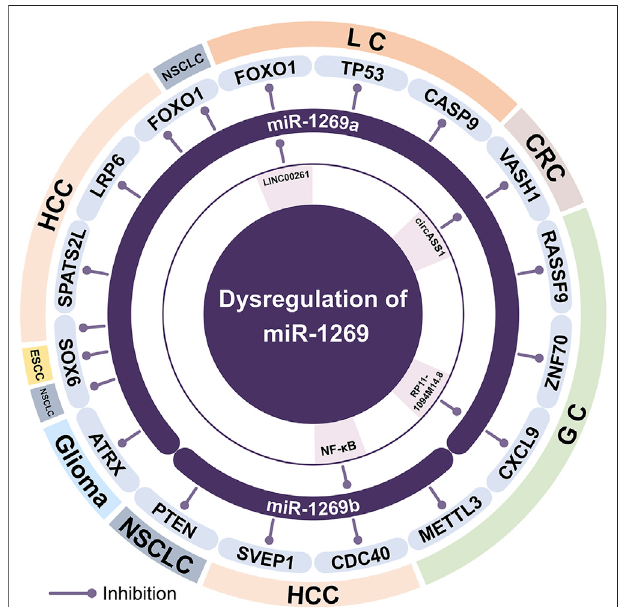
FIGURE 1 | The dysregulation of miR-1269a and miR-1269b in different cancers. miR-1269a can be regulated by three upstream ncRNAs. miR- 1269a and miR-1269b can regulate the occurrence and development of cancer by targeting downstream genes. HCC, Hepatocellular carcinoma; GC, Gastric cancer; CRC, Colorectal cancer; NSCLC, Non-small cell lung cancer; ESCC, Esophageal squamous cell carcinomas; LC, Lung